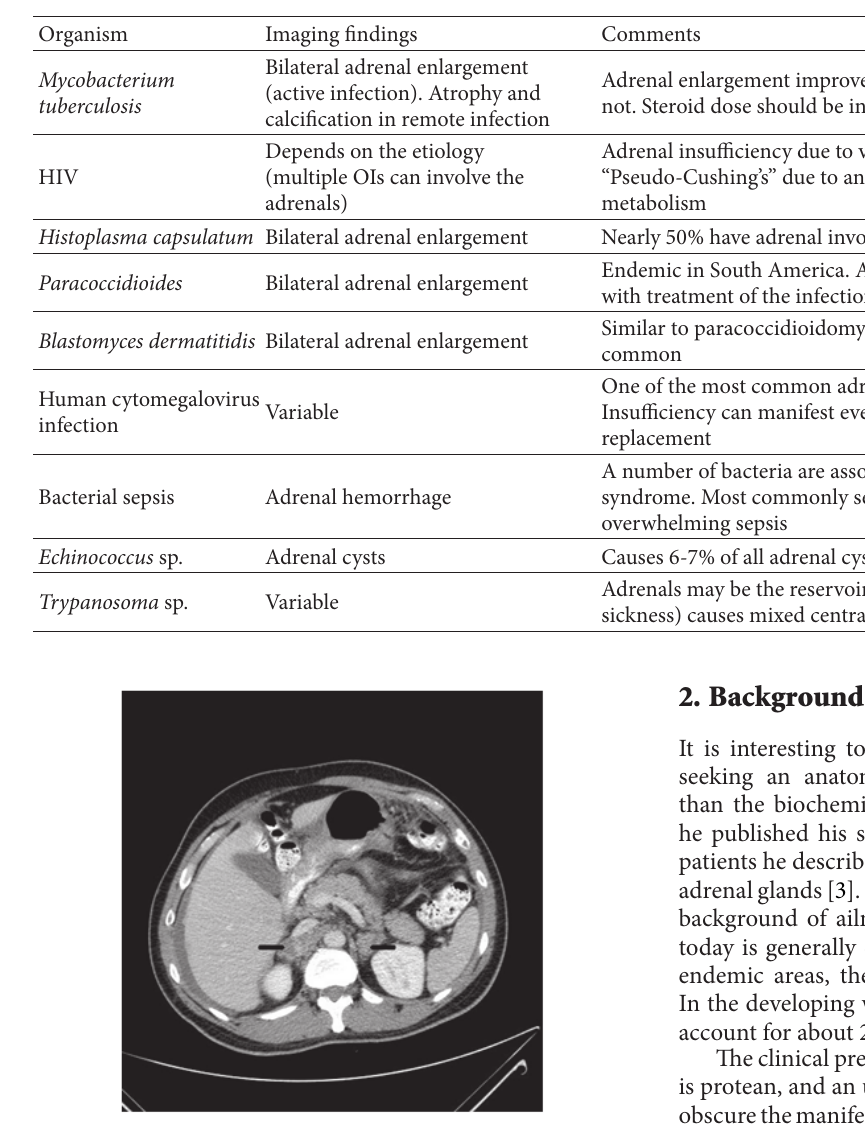
Table 1: Salient features of various adrenal infections.